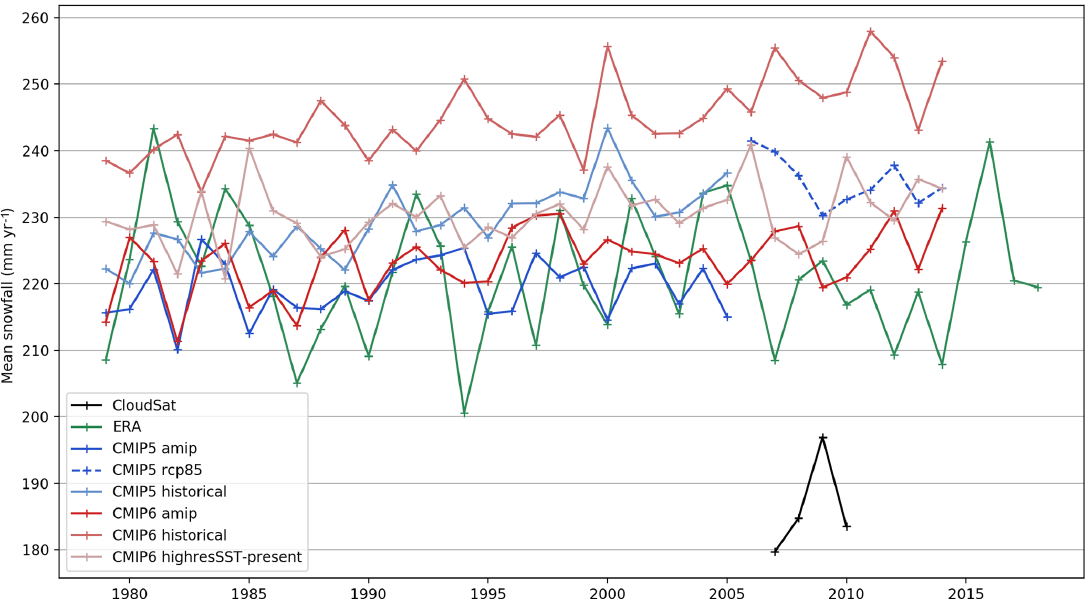
Figure C1. The 1979 to 2018 time series of mean annual snowfall rate over the entire Antarctic continent. The median values for all the models of each CMIP (5 and 6) and the mean values for CloudSat and ERA5 are